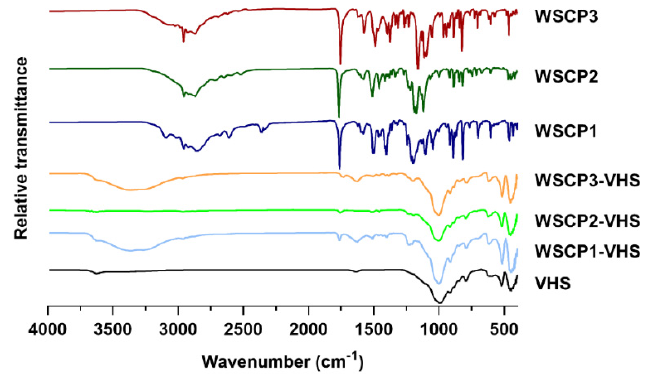
Figure 5. Nanohybrids and raw components analyzed by Fourier transform infrared (FTIR).